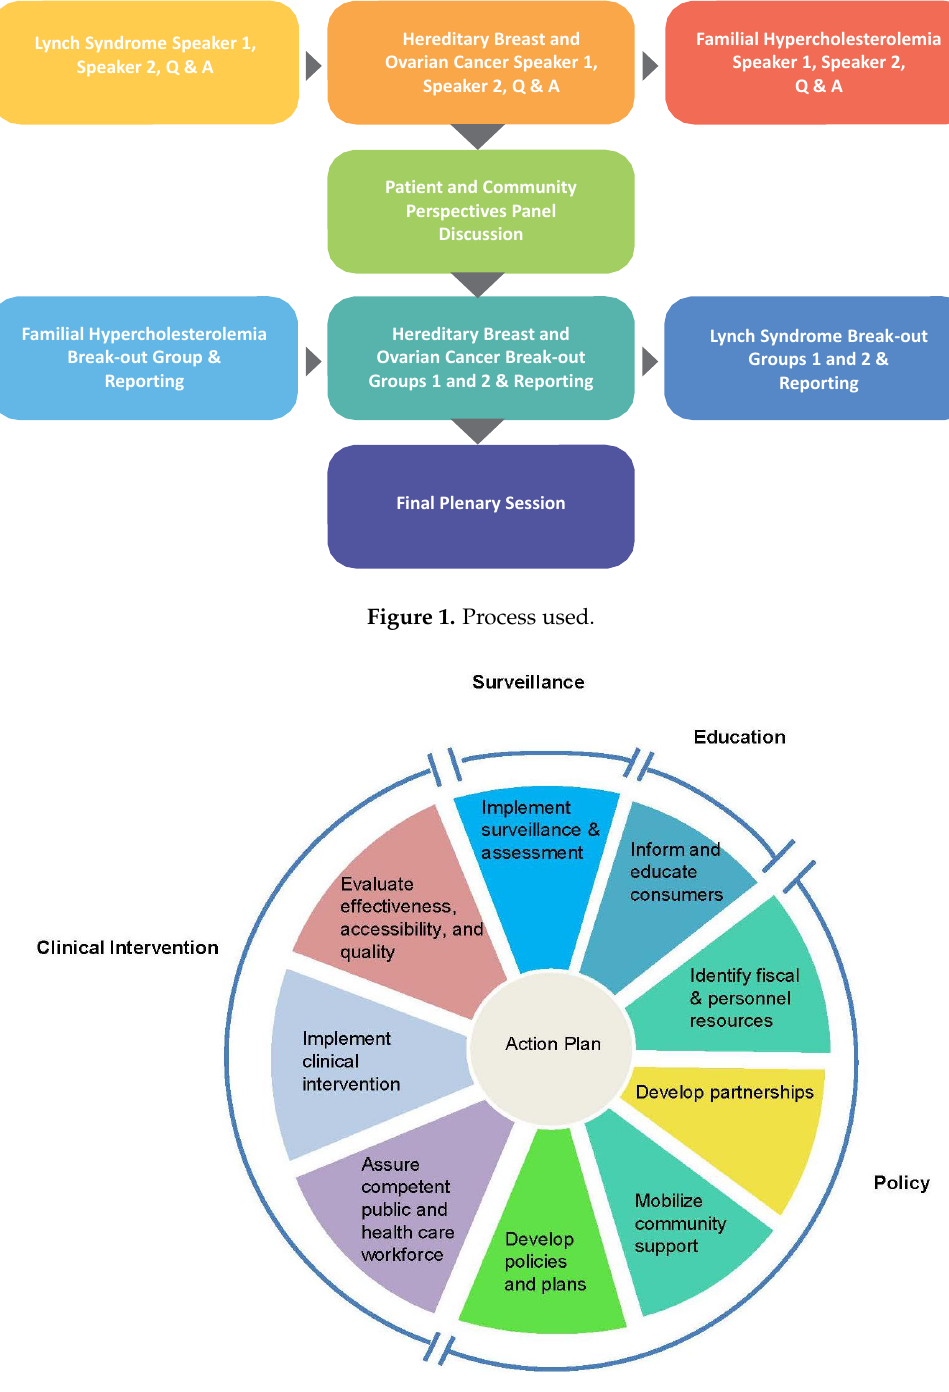
Figure 2. Essential public health functions framework.